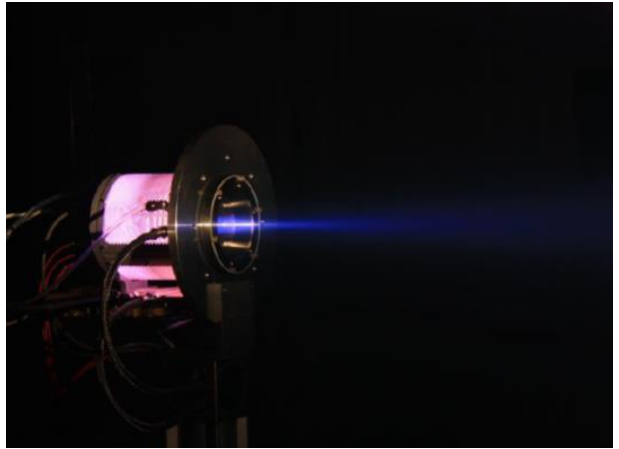
Figure 5: RIT10/37 thruster in operation in the